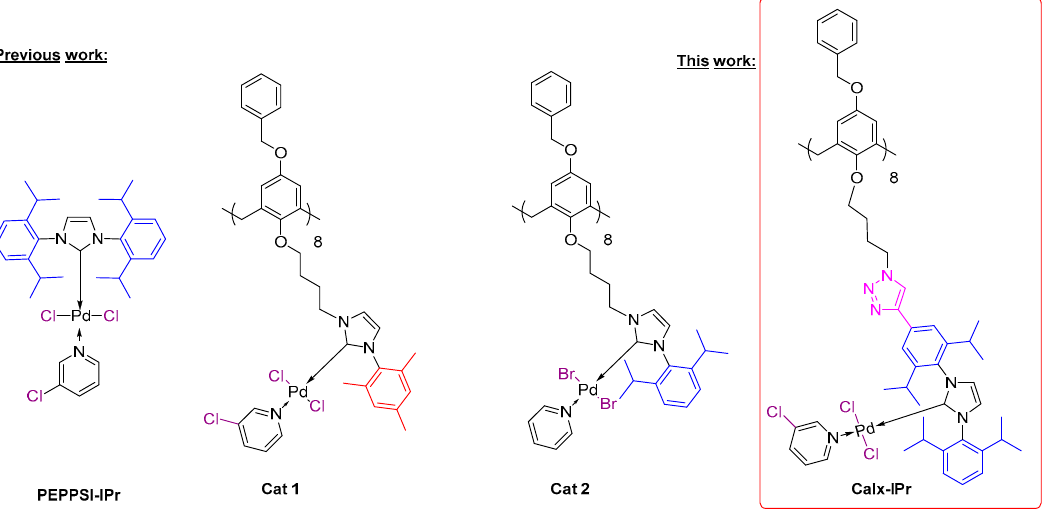
Figure 1. Previously described calix[8]arene-based catalysts Cat1 and Cat2 and new catalyst Calx-IPr.